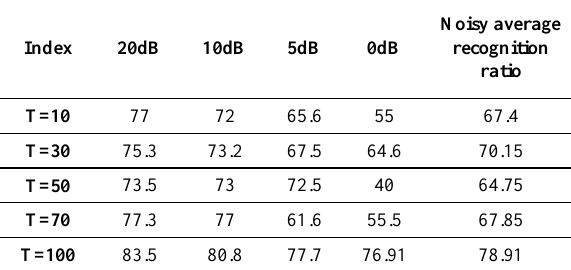
Table 1. Various index was experimented to select the best and appropriate index (T: threshold) to be removed at autocorrelation segment in AGCR-MFCC. Experiment results show that the highest noisy average recognition ratio belong to T=100.